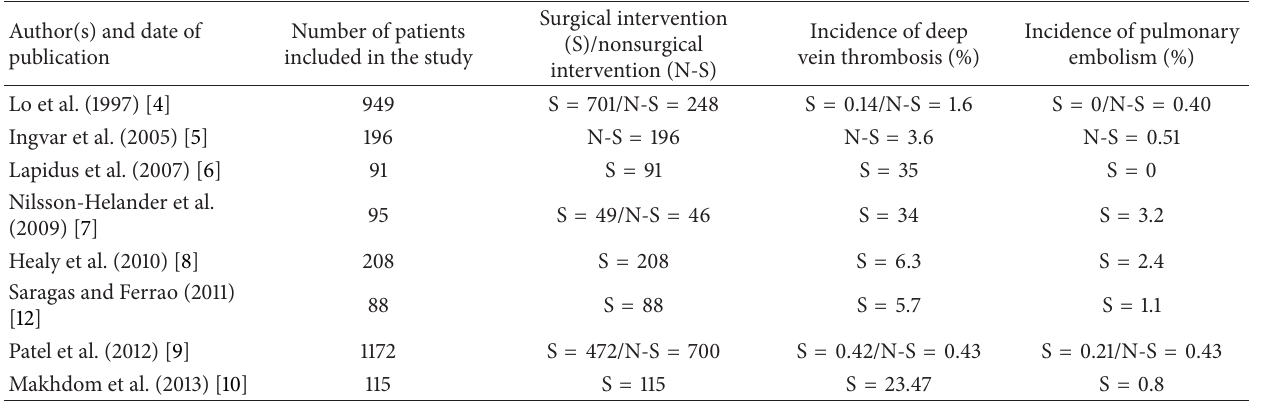
Table 1: Reported incidence of deep vein thrombosis and pulmonary embolism in patients treated surgically (S) and nonsurgically (N-S) for Achilles tendon